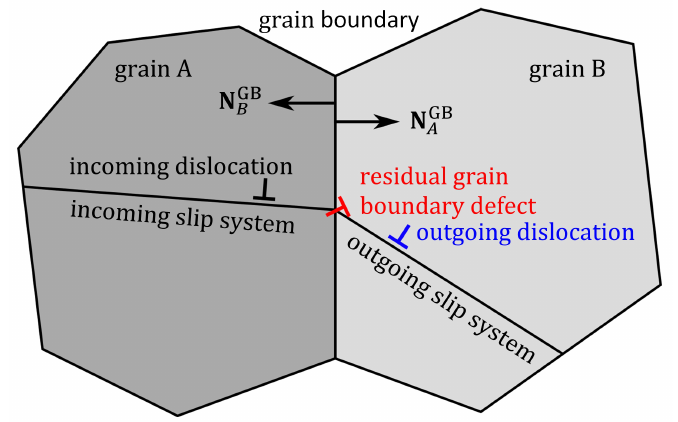
Figure 1. Schematic of slip transmission: dislocations from an incoming slip system in grain A propagate through the grain boundary Ω AB onto the outgoing slip system in grain B . The transmission of each dislocation produces a residual grain boundary